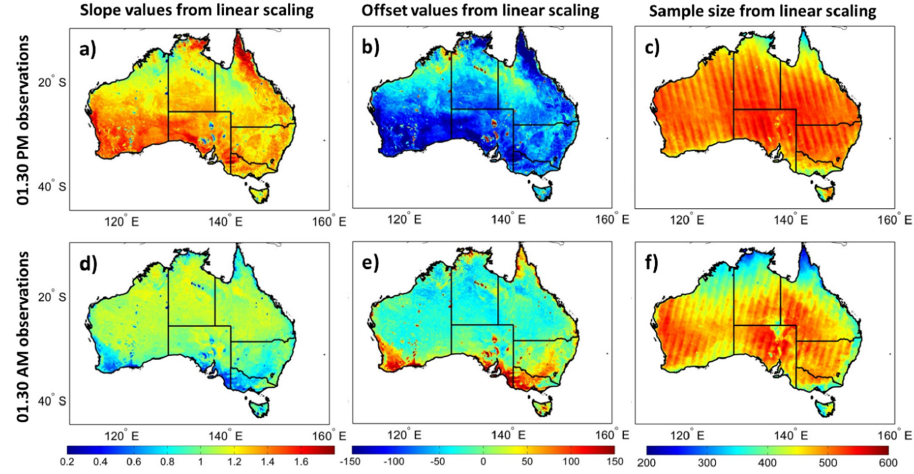
Figure 4. Pixel based scaling parameters (slope and offset) for MODIS Land Surface Temperature and AMSR2 (T b, 37V ) observations. The slope ( a ); offset ( b ) and the sample sizes ( c ) for day-time observations and the slope ( d ); offset ( e ) and the sample sizes ( f ) for night-time observations.